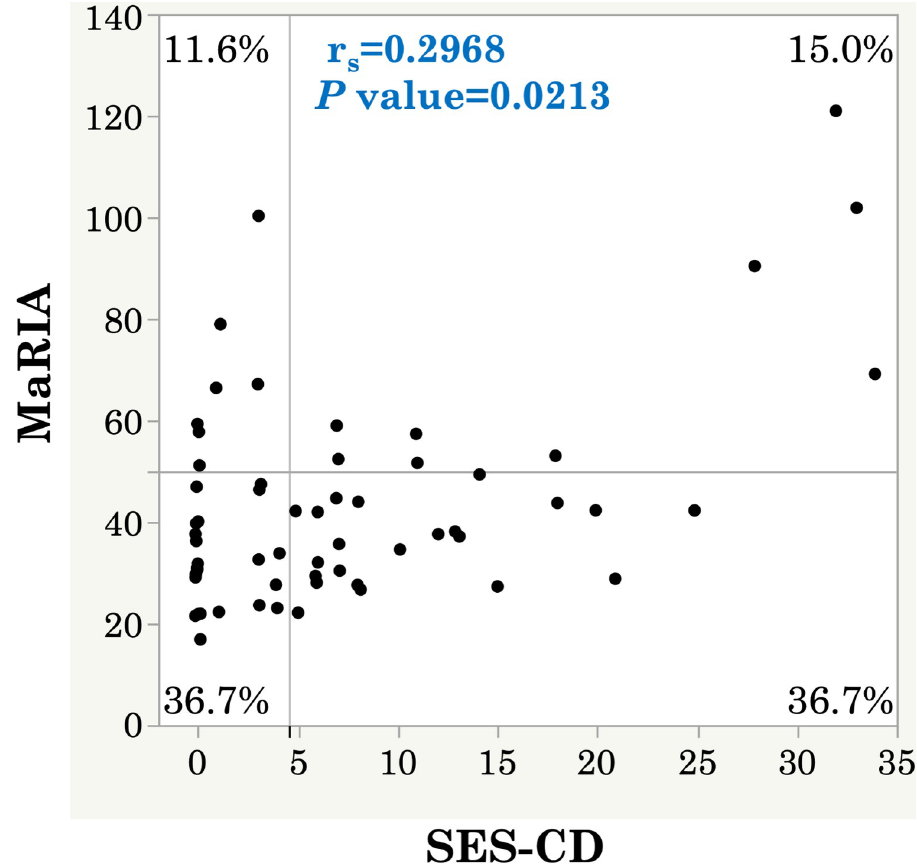
Fig 1. Correlation between SES-CD and MaRIA score (per